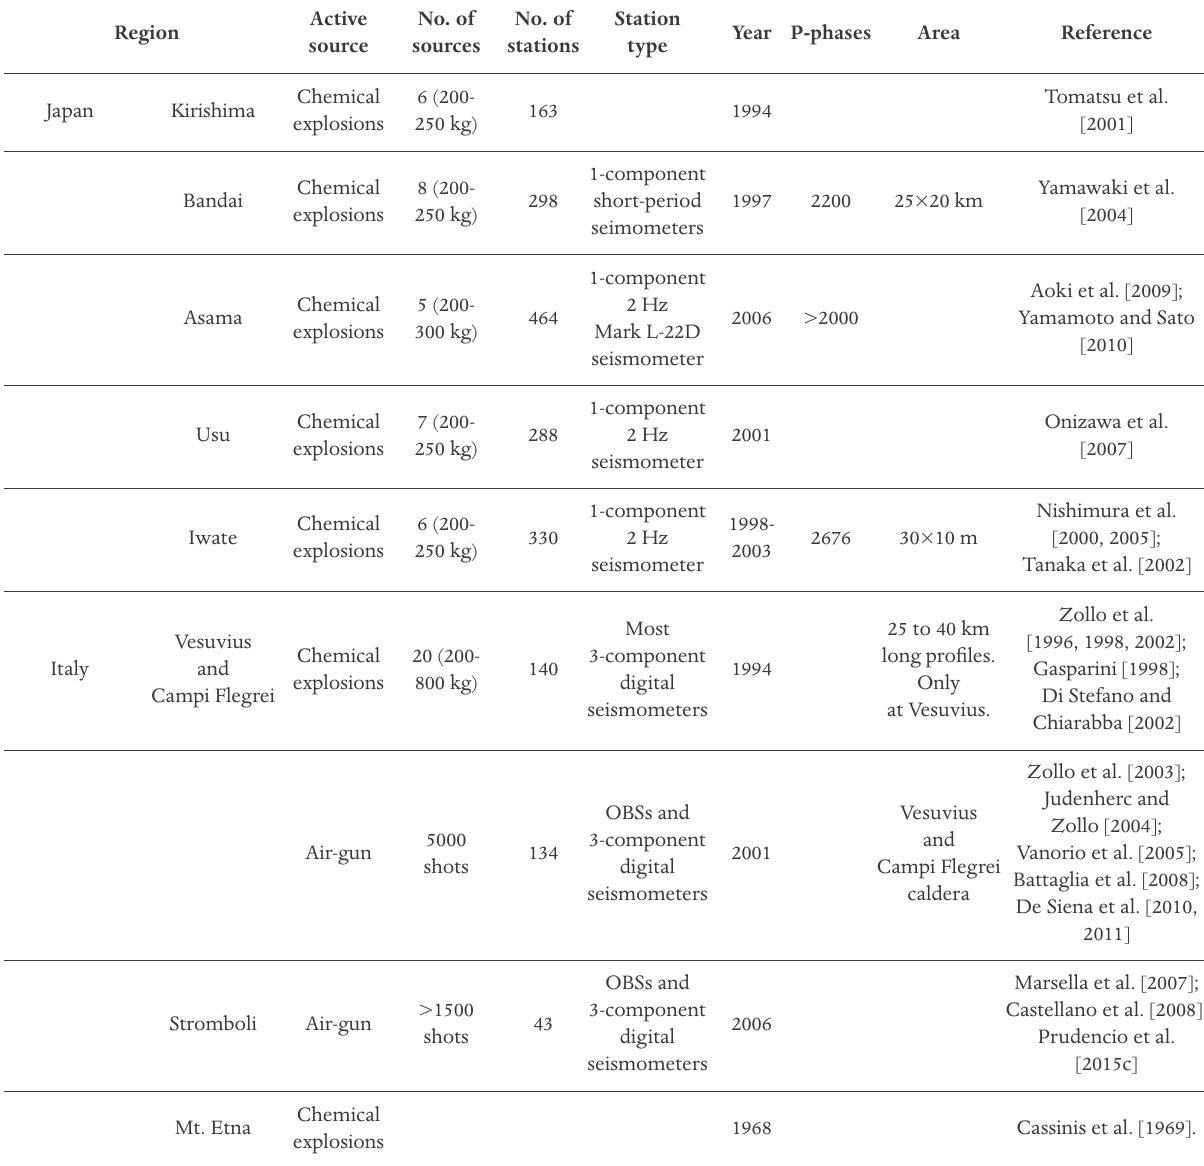
Table 1. Brief summary of the most important active seismic experiment performed over the world during the las 20 years. (Table contin- ues on next